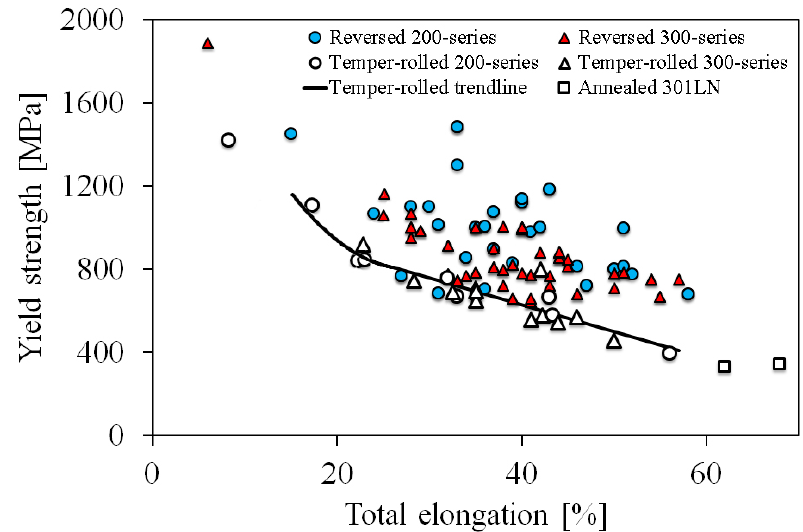
Figure 10. Yield strength-total elongation combinations for some reversion-treated steels listed in Table 2 compared to those of annealed 301LN and temper-rolled 301LN and 201L steel.